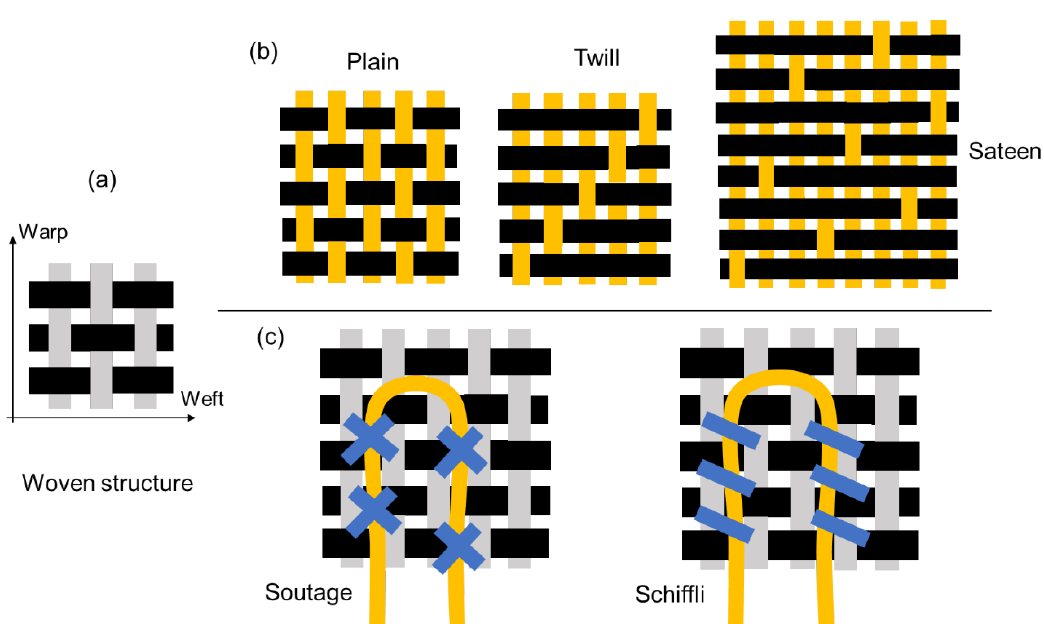
Figure 6. Optical fibers in woven structures: ( a ) basic woven structure; ( b ) optical fibers in plain, twill, and sateen structures; ( c ) optical fibers in woven structure with embroidering techniques (optical fibers marked yellow).